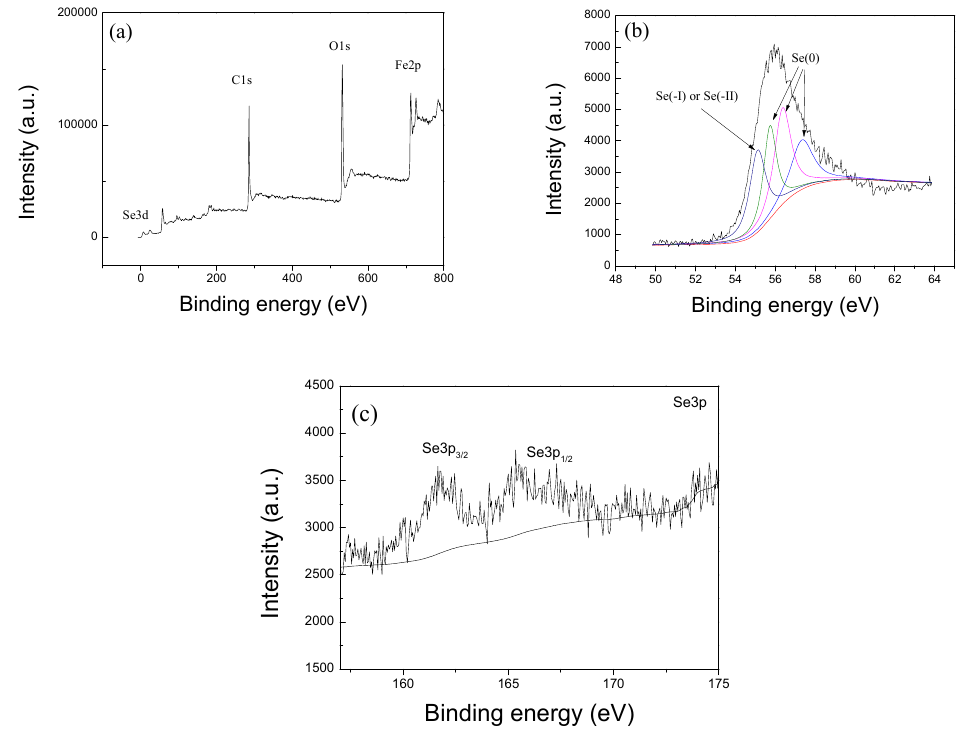
Figure 12. Wide-scan XPS survey of nZVI/rGO-Se(IV) ( a ); high-resolution spectrum of Se 3d for nZVI/rGO-Se(IV) ( b ); the XPS spectra of Se 3p for nZVI/rGO-Se(IV) ( c